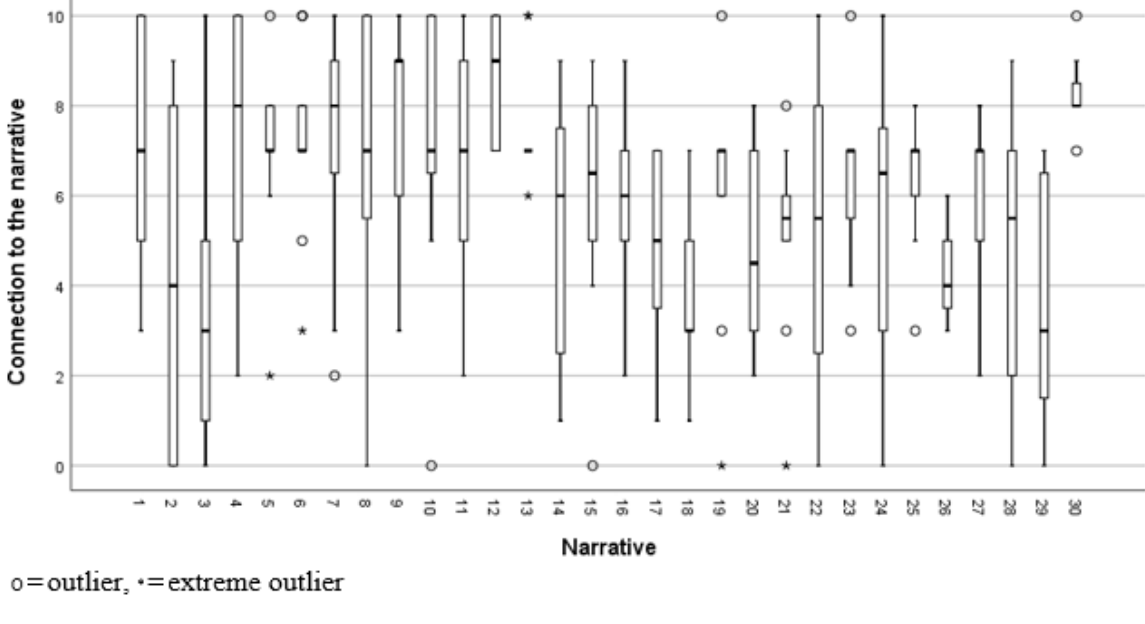
Figure 2. Ratings by participants (N=40) of connection to the narrative.